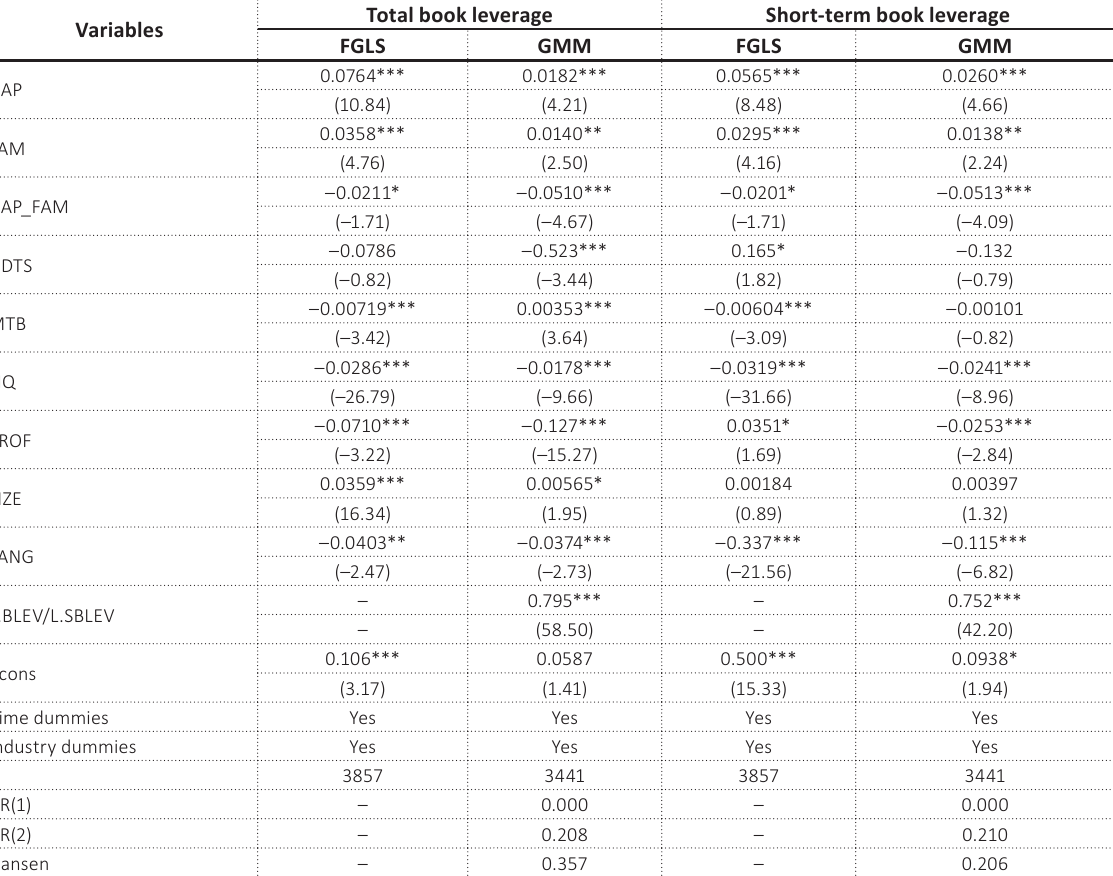
Table 6. Feasible GLS and System GMM regression